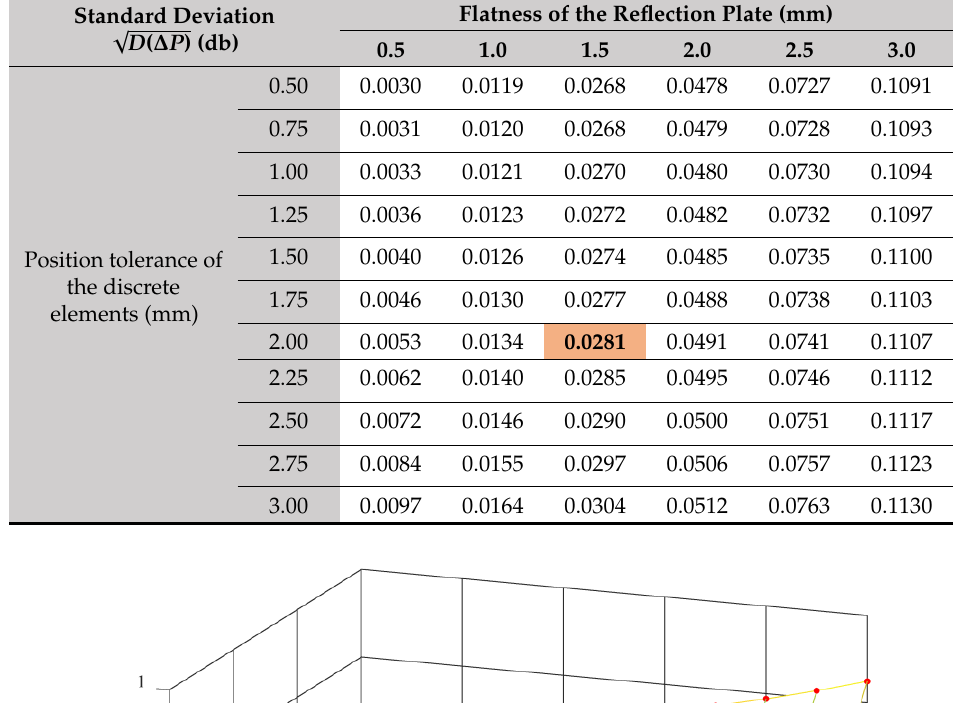
Table 2. The standard deviation of the maximum power density degradation.